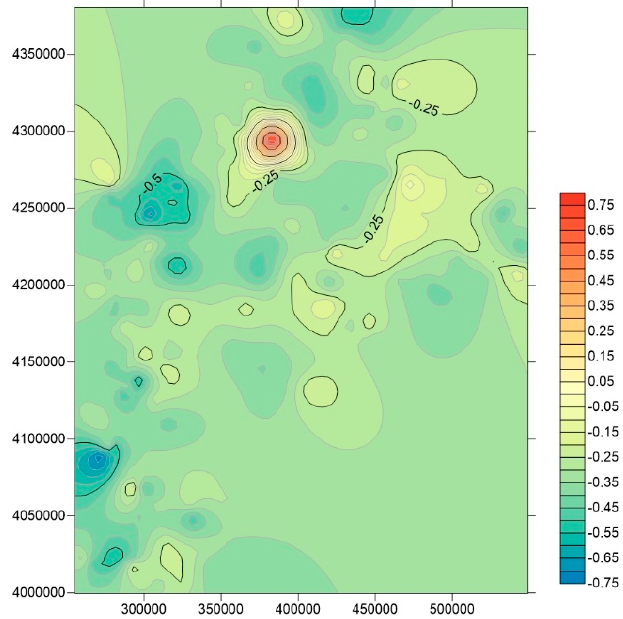
Figure 5 . The Spatial prediction map of the comprehensive pollution index. Figure 5. The Spatial prediction map of the comprehensive pollution